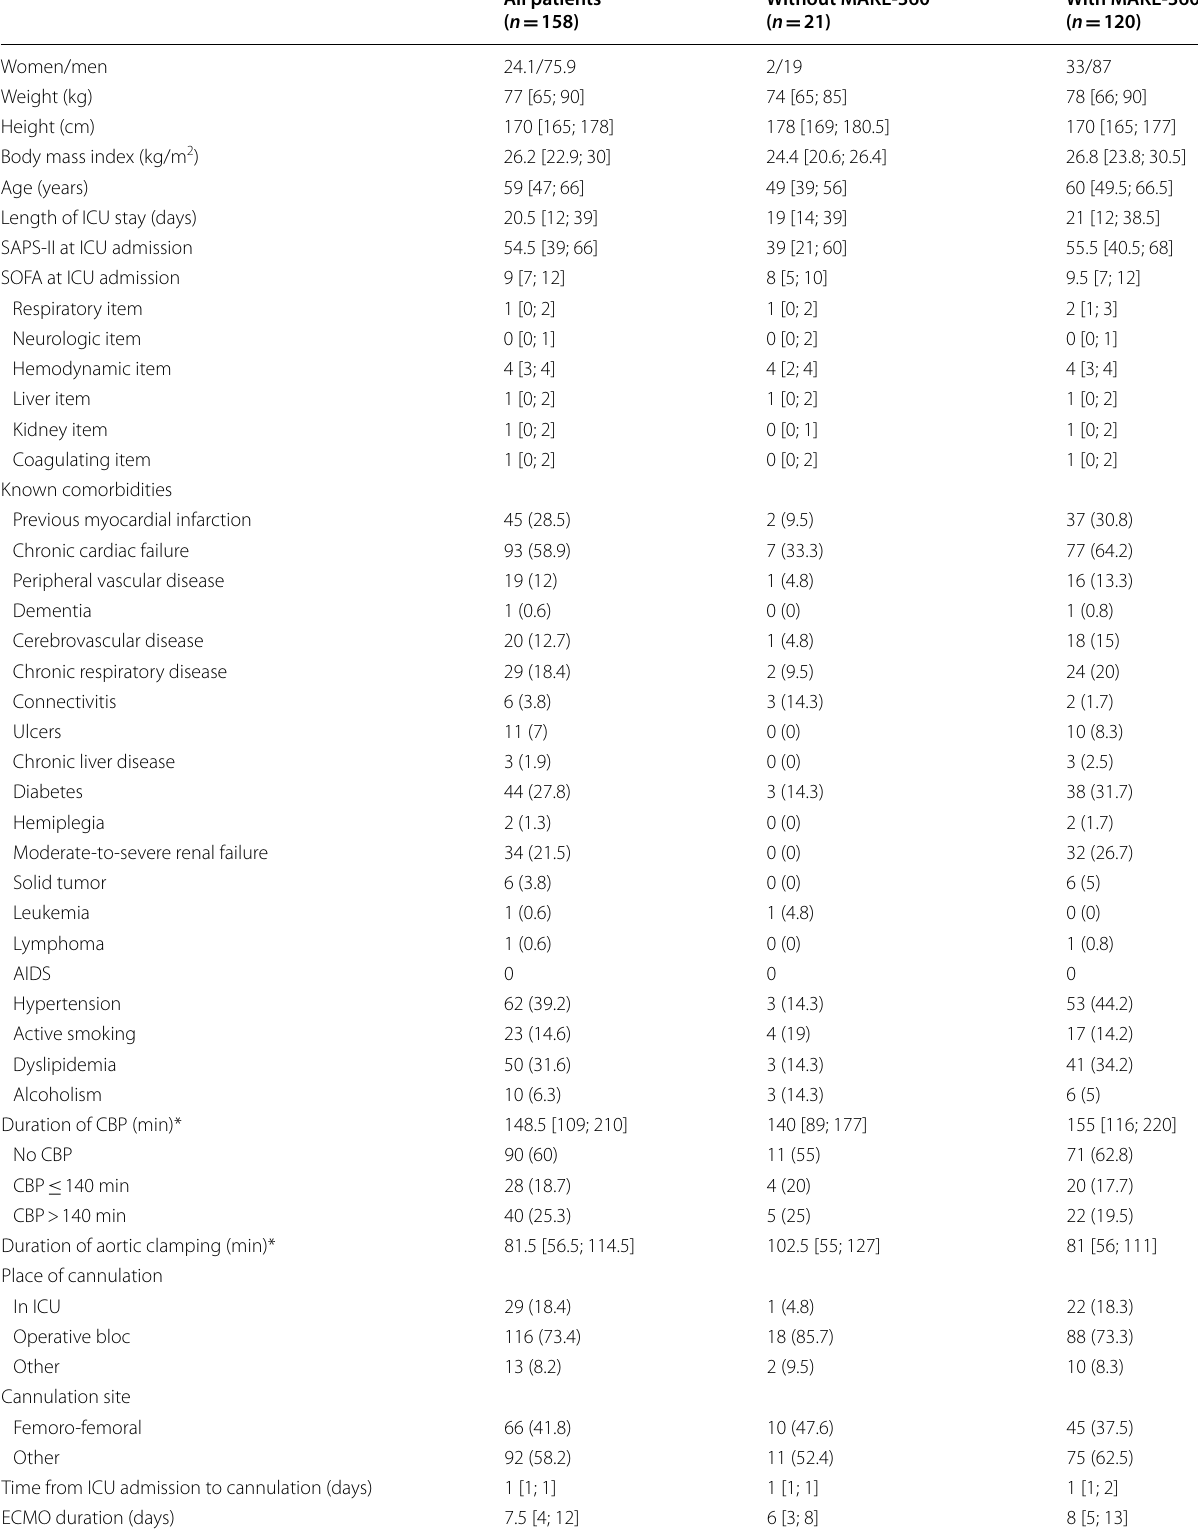
Table 1 Population